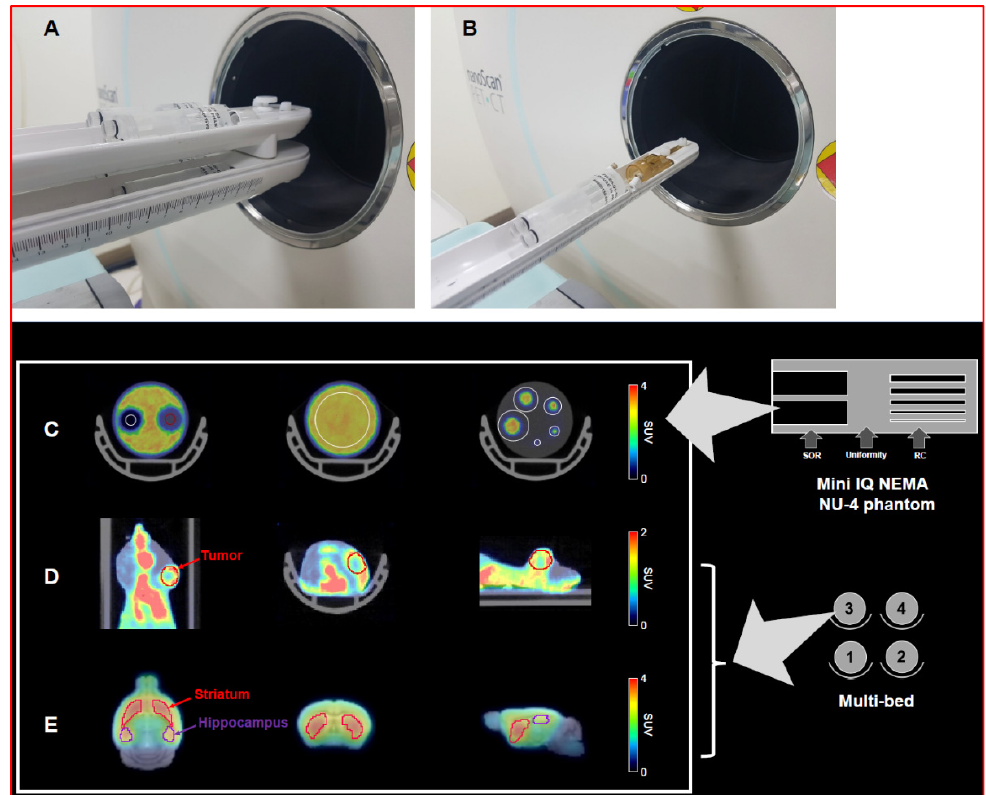
Figure 1. Design of the multi-bed ( A ) and single-bed PET imaging system ( B ). Definition of the VOIs in the mini IQ NEMA Nu-4 image quality phantom ( C ) each volume of interest (VOI)was drawn to calculate following factors; spill-over ratio (left), uniformity (middle), recovery coefficient (right)). The VOIs for the tumor region ( D ) and the brain (striatum and hippocampus, ( E )) are also represented.